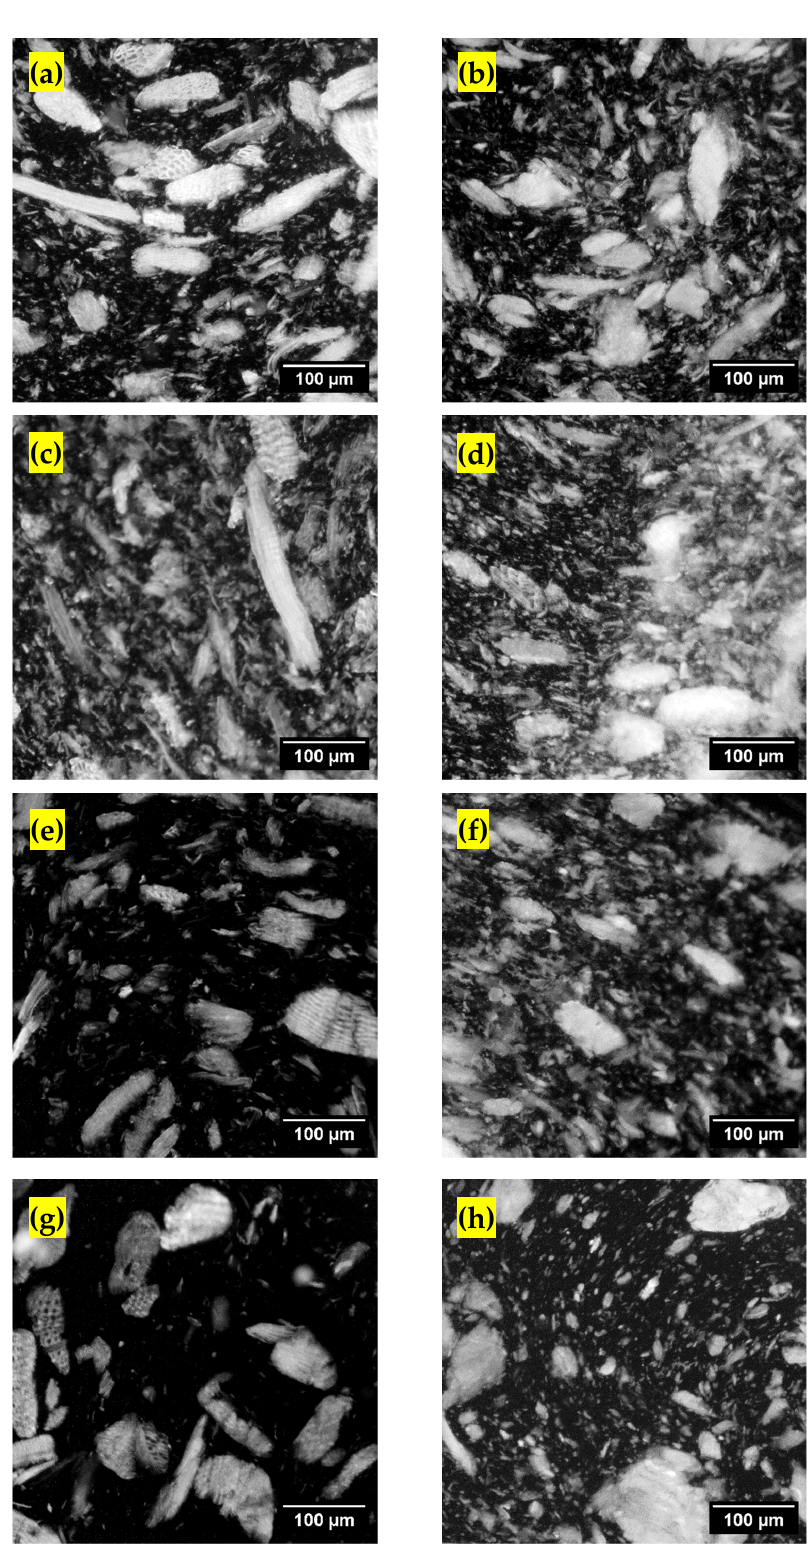
Figure A1. Fluorescent images of WPCs in controlled condition ( a ) Cedar flour, ( b ) Cedar pellets, ( c ) Pine flour, ( d ) Pine pellets, ( e ) Spruce-fir flour, ( f ) Spruce-fir pellets, ( g ) Maple flour and ( h ) Maple pellets.